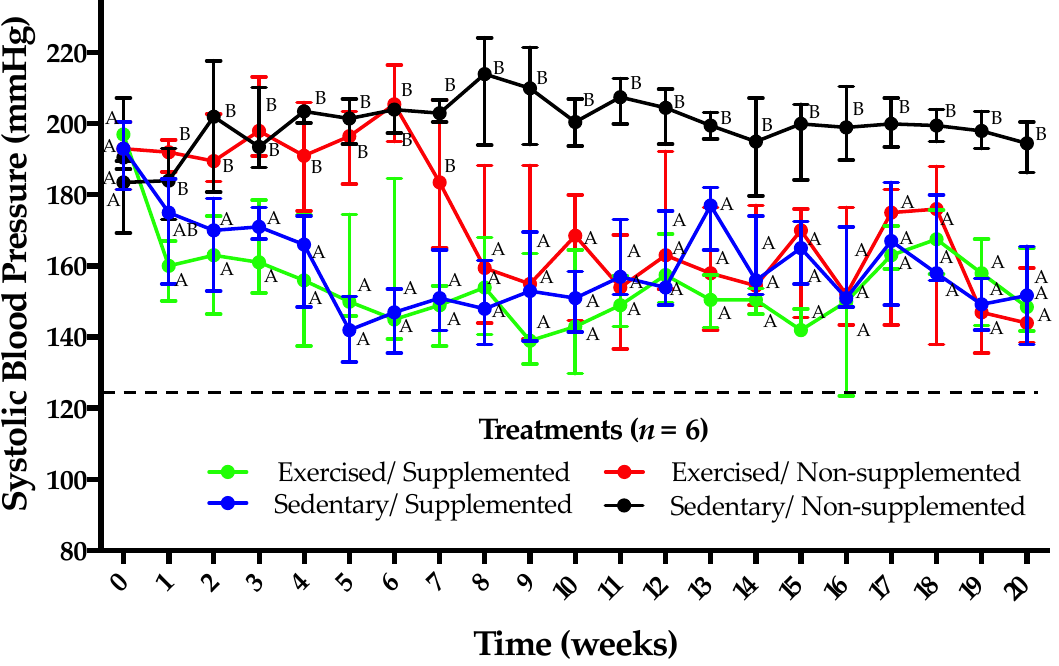
Figure 3. Evaluation of SBP in SHR. SHR ( n = 24) were randomly allocated into four groups: exercised / supplemented, sedentary / supplemented, exercised / non-supplemented, and sedentary / non-supplemented. Supplementations consisted of amaranth hydrolysate (1.2 g / kg body weight). See Figure 1 for physical activity details. The dotted line represents the average SBP of eight aged-matched normotensive rats. Di ff erent letters (A, B, or C) indicate significant di ff erences among groups at the same week. The data were analyzed by Kruskal-Wallis test. The results are shown as medians with interquartile range.